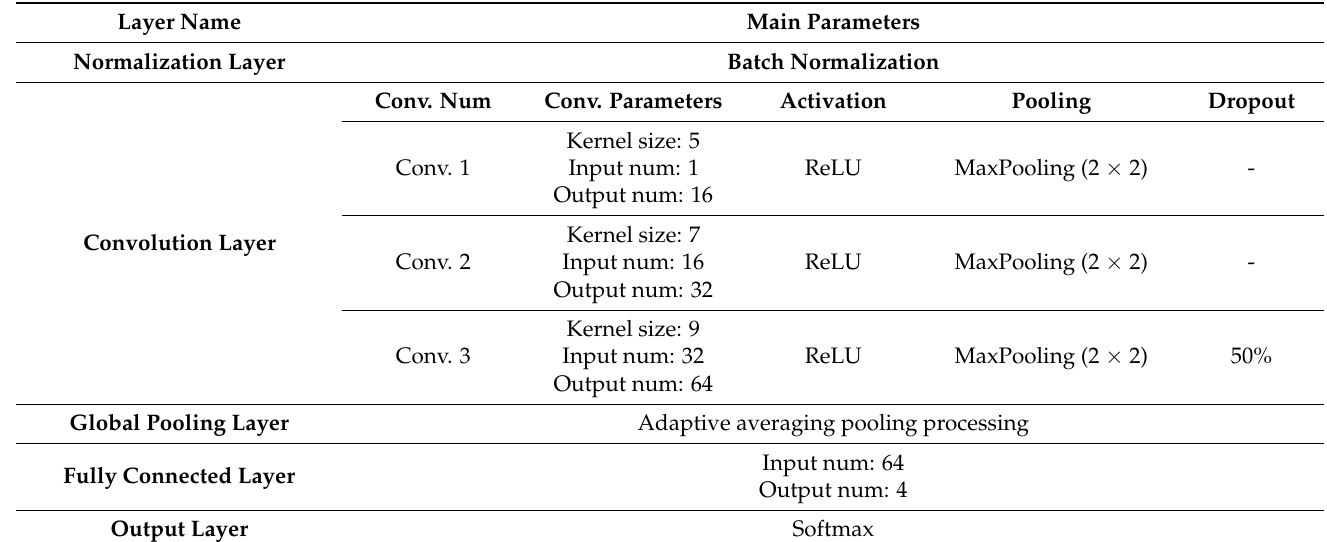
Table 2. The structure and parameter settings of